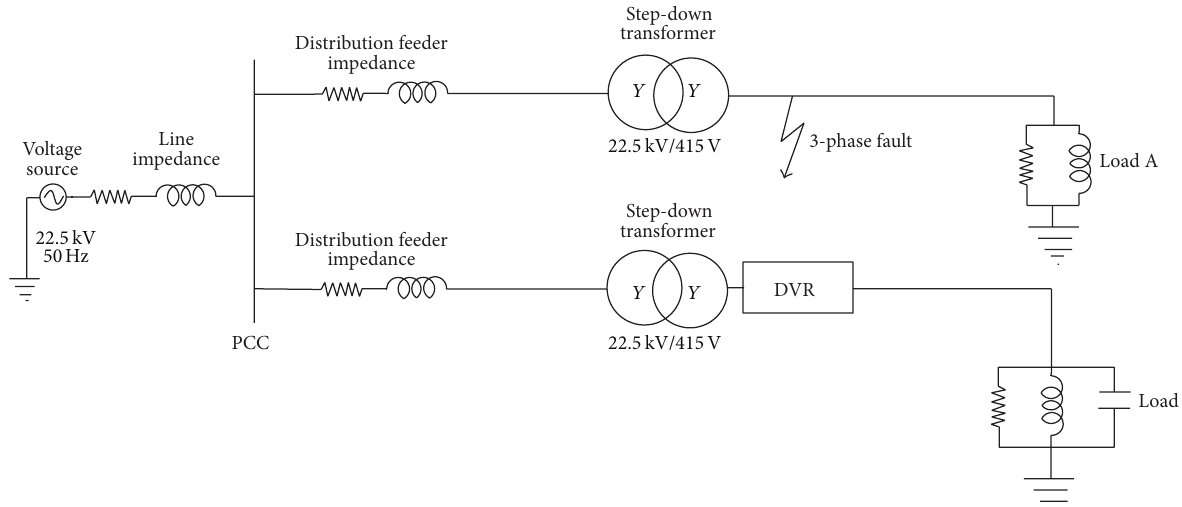
Figure 1: Test system with three-phase balanced